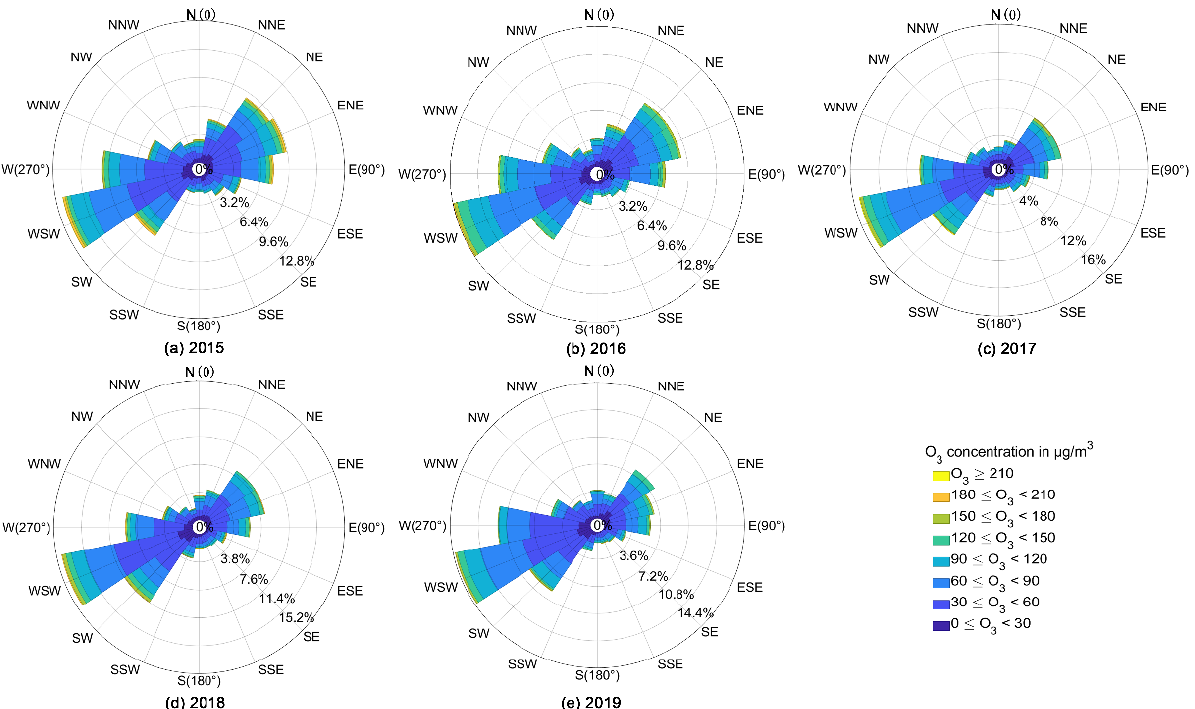
Figure 9. O 3 concentration rose map of Jilin from 2015 to 2019.